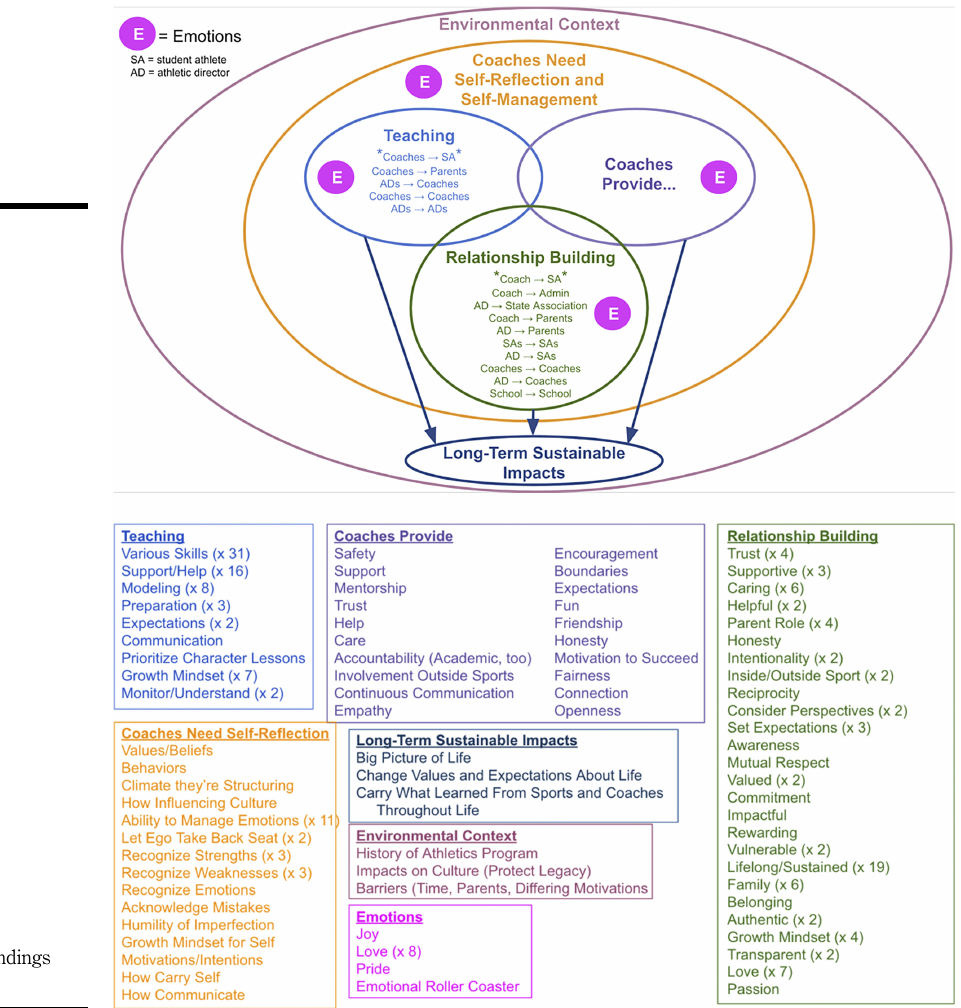
Figure 2. Thematic findings from